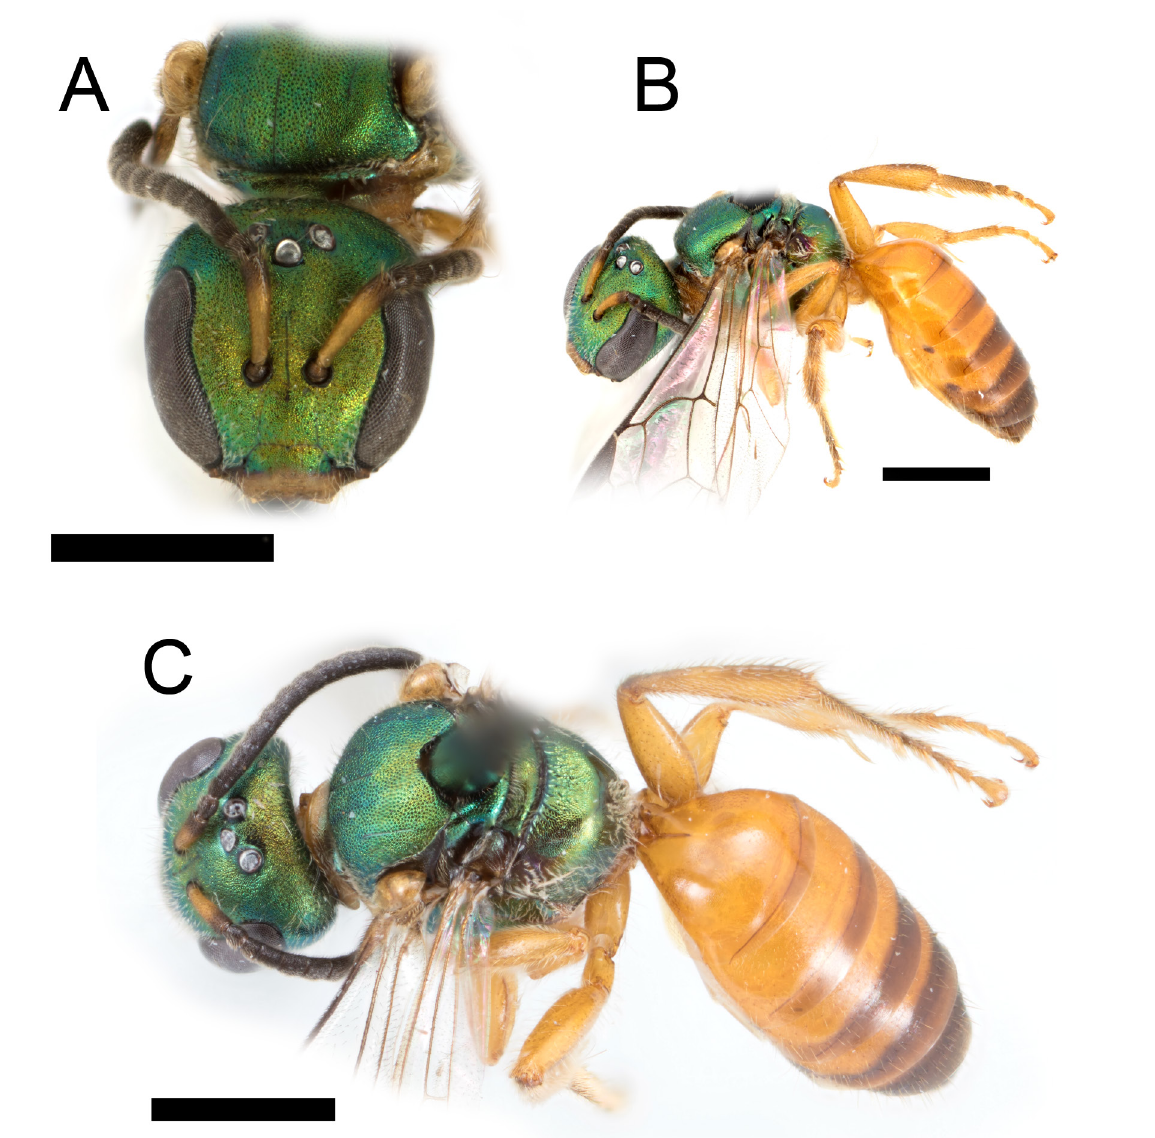
Fig. 25. Lasioglossum eickwortellum (Engel, 2001), ♂. A . Face. B . Lateral habitus. C . Dorsal habitus. Scale bars = 1